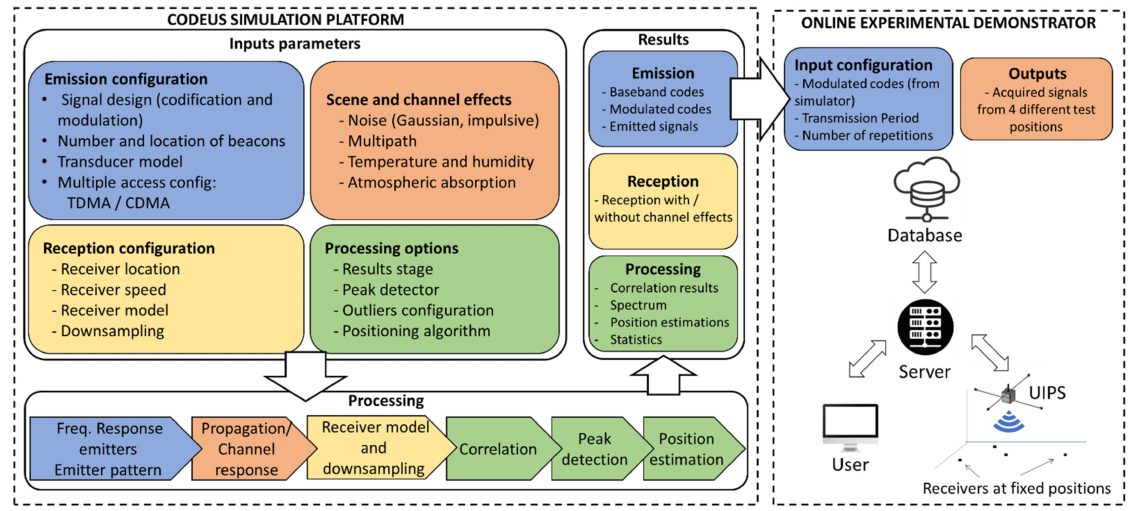
Figure 1. General block diagram of the CODEUS platform: simulator and online